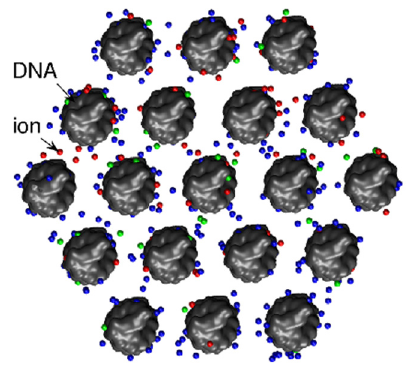
Figure 9. Condensed dsDNA helices packaged in hexagonal arrays, as viewed from the axis. Reproduced from [102]. Copyright (2013) with permission from